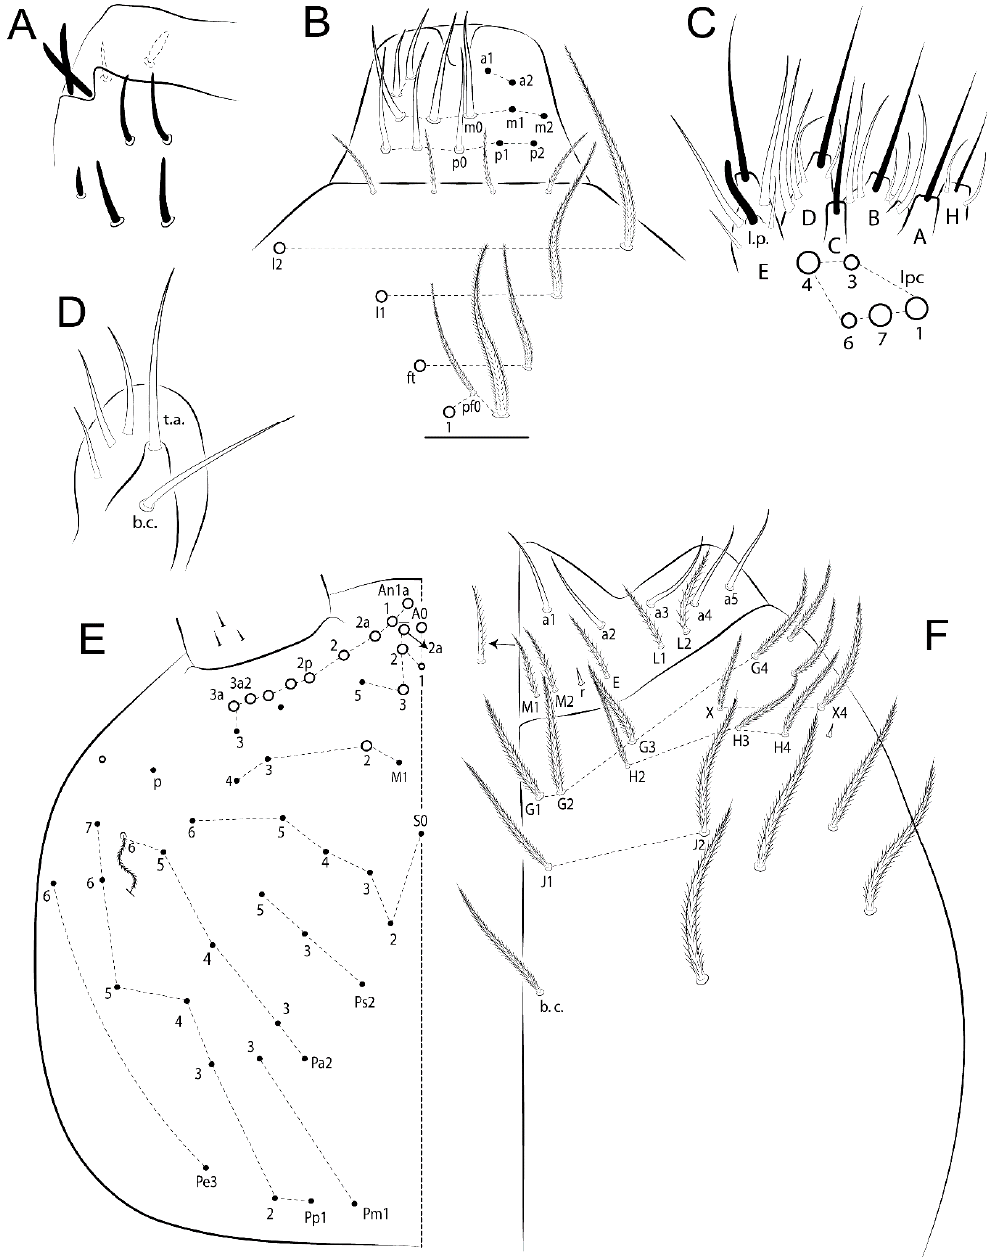
Figure 55. Pseudosinella neriae sp. nov.: head. ( A ) Ant III apical organ (ventro-lateral view); ( B ) chaetotaxy of clypeus, prelabrum, and labrum; ( C ) labial papillae plus proximal chaetae (left side); ( D ) maxillary palp and sublobal plate (right side), minute appendage omitted; ( E ) head dorsal chaetotaxy (left side); ( F ) basomedian and basolateral labial fields and complete postlabial chaetotaxy (right side).